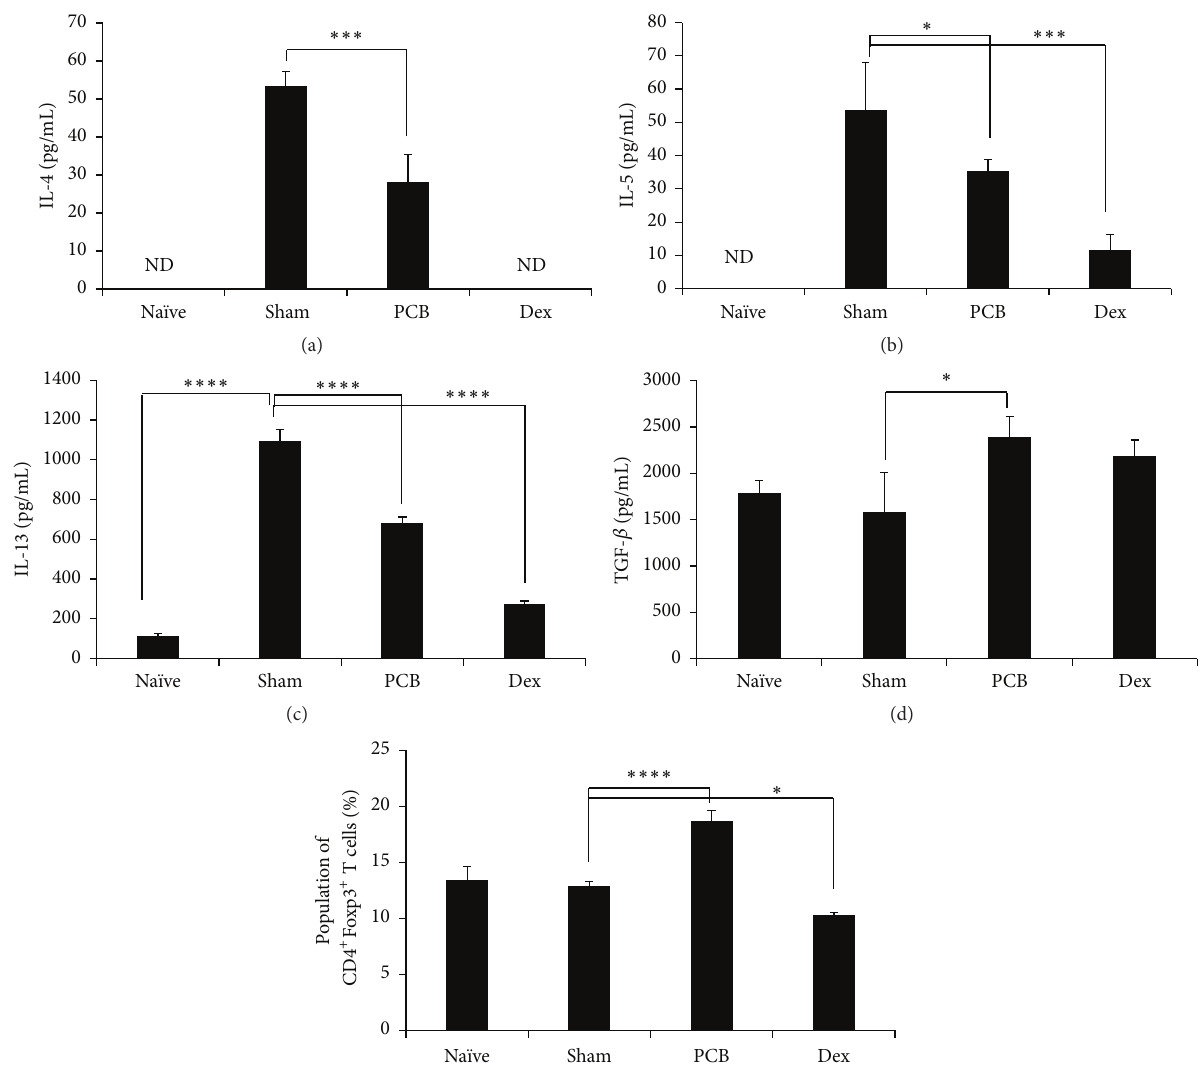
Figure 5: Immunomodulatory effects of PCB extract on cytokine expression patterns in mesenteric lymph nodes of food allergic mouse. Mice were sacrificed by cervical dislocation on day 35, and mLNs were isolated. mLNs were cultured in RPMI medium containing 10% fetal bovine serum for 72 h. Cytokines secreted from mLNs were quantified by ELISA. Interleukin- (IL-) 4 (a), IL-5 (b), IL-13 (c), and TGF- 𝛽 (d) were measured. (e) The expression of Foxp3 in gated CD4 + cells was analyzed using flow cytometry. Data are presented as the mean of the percentage of Foxp3 + CD4 + T cells from three independent experiments and as mean ± SD. Data were analyzed using one-way repeated measure ANOVA followed by Dunnett’s post hoc test. Bars represent significant differences from the sham group at ∗ 𝑃 < 0.05 , ∗∗∗ 𝑃 < 0.001 , and ∗∗∗∗ 𝑃 < 0.0001